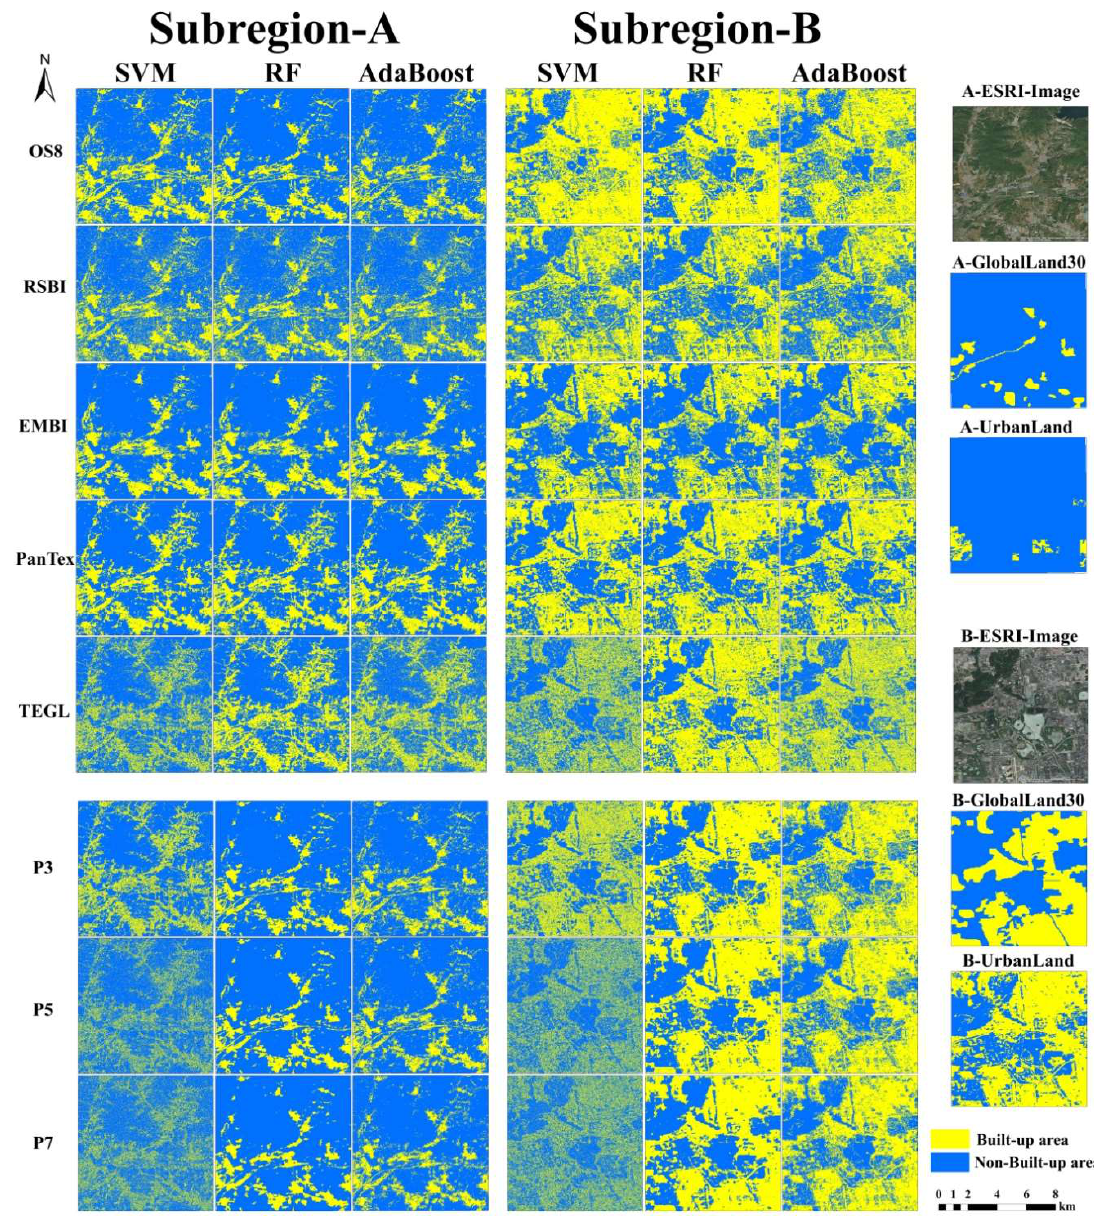
Figure 7. Classification results based on feature engineering. (The first five rows are the classification results of three classifiers within five set features. The last three rows are the classification results of three classifiers within three kinds of image patch.)